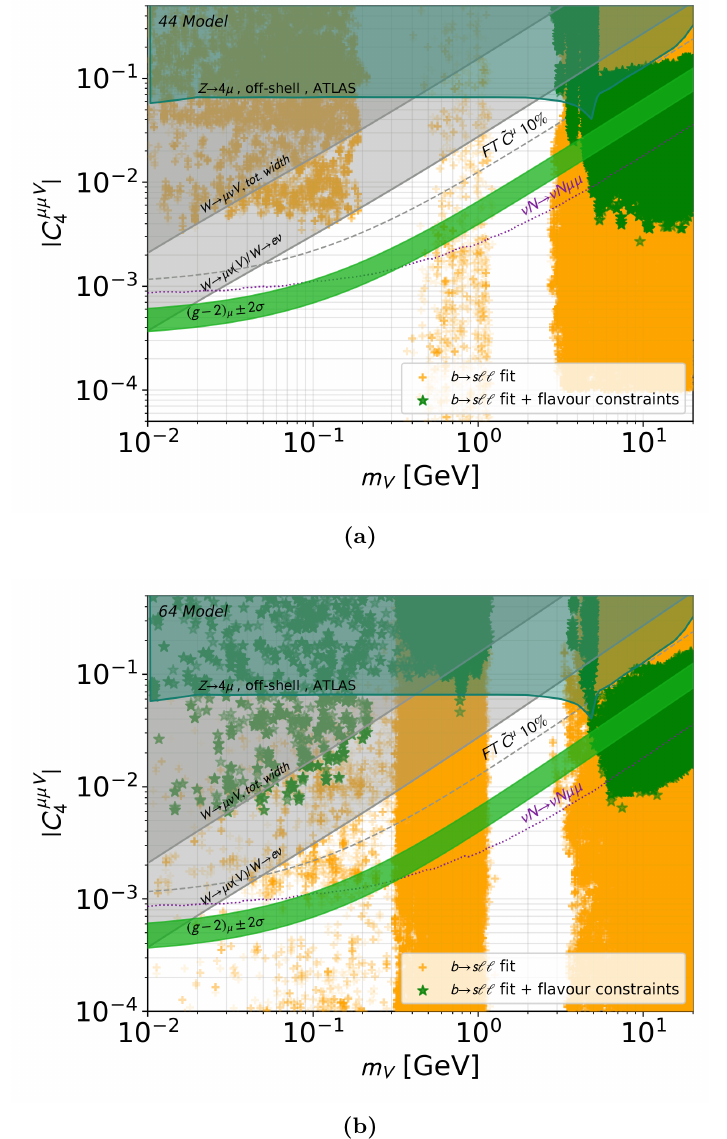
Figure 3. Constraints on the parameter space consistent with the LFUV anomalies (yellow points) in the plane of C µµV